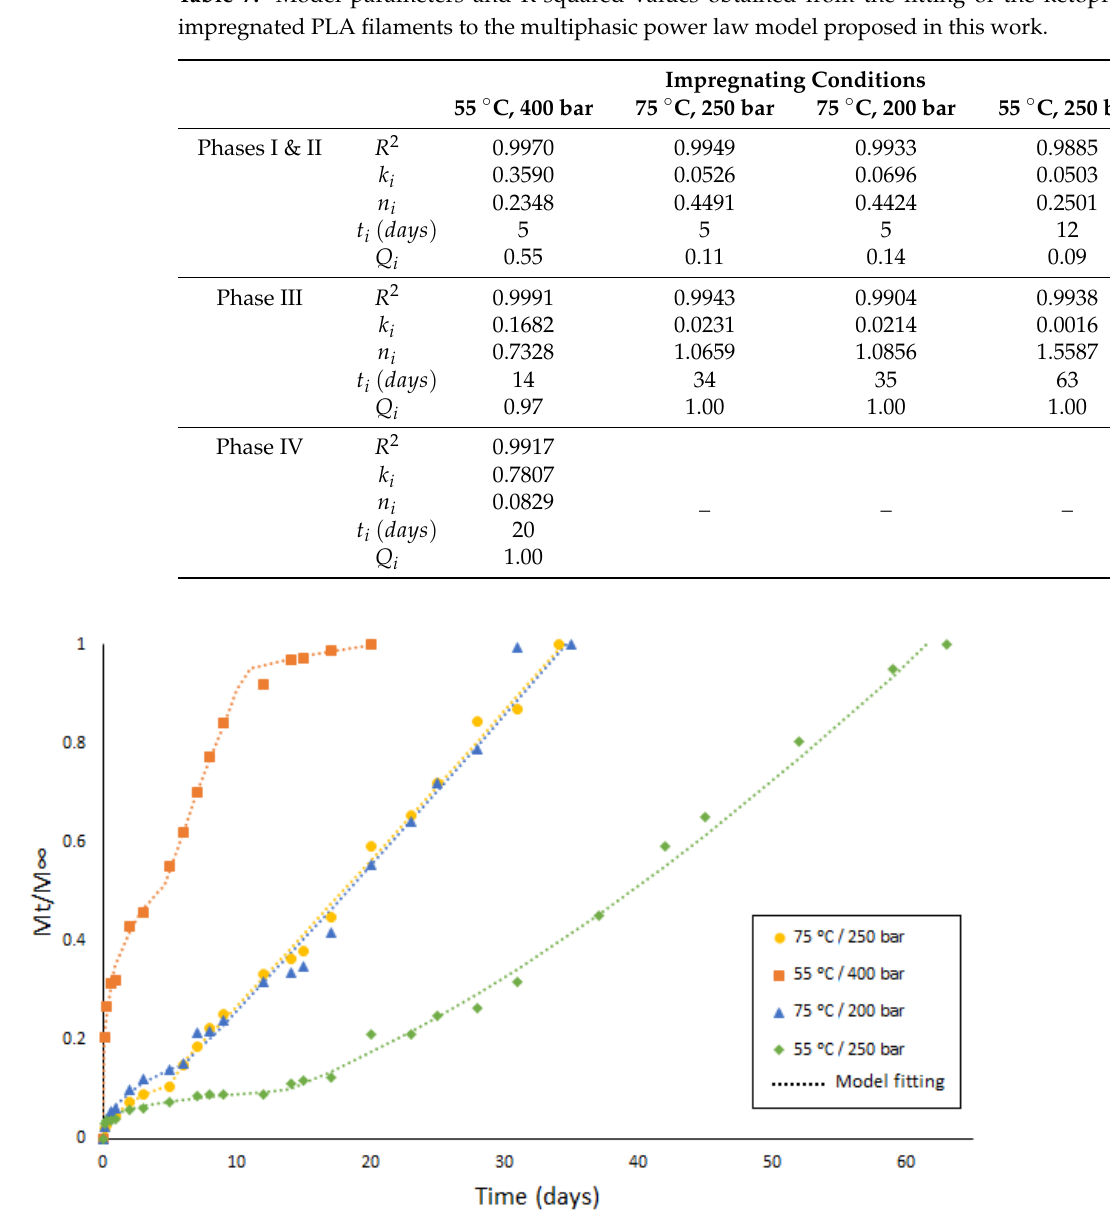
Figure 9. Fitting graphs of the ketoprofen-impregnated PLA filaments to the multiphasic power law model. It can be seen from the R-square values that the fit was quite good. The diffusion phases I and II are expressed according to an exponential release profile, where